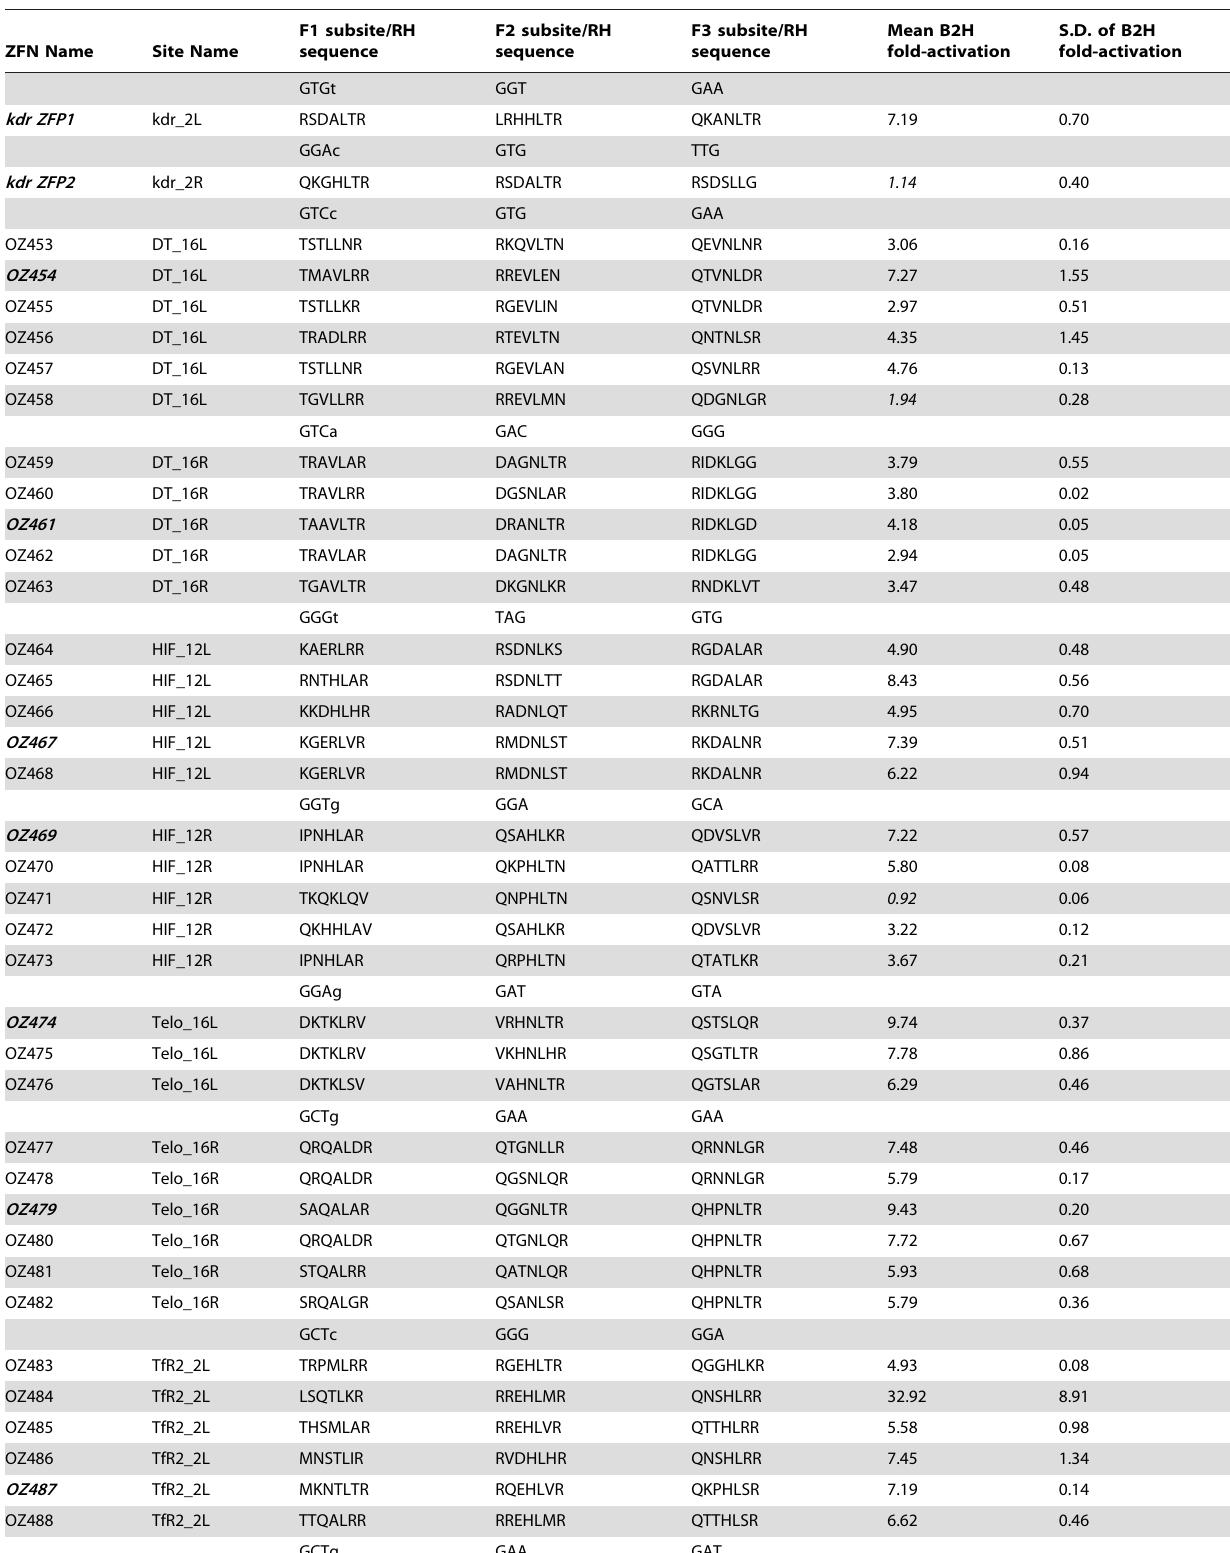
Table 1. Recognition helix (RH) amino acid sequences and B2H activities of zinc finger arrays for endogenous zebrafish gene